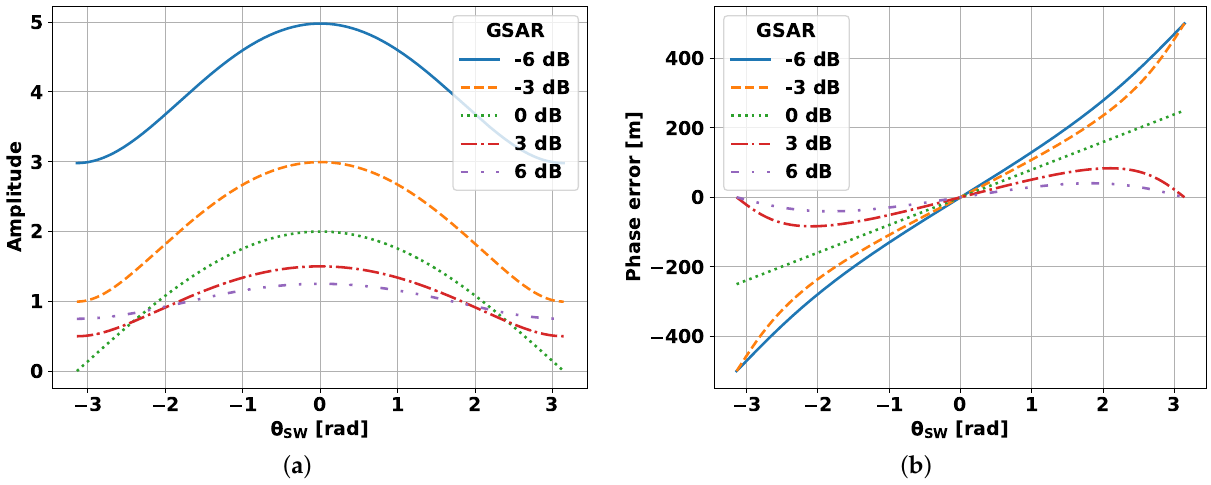
Figure 3. Amplitude ( a ) and phase error ( b ) for different GSAR and θ SW